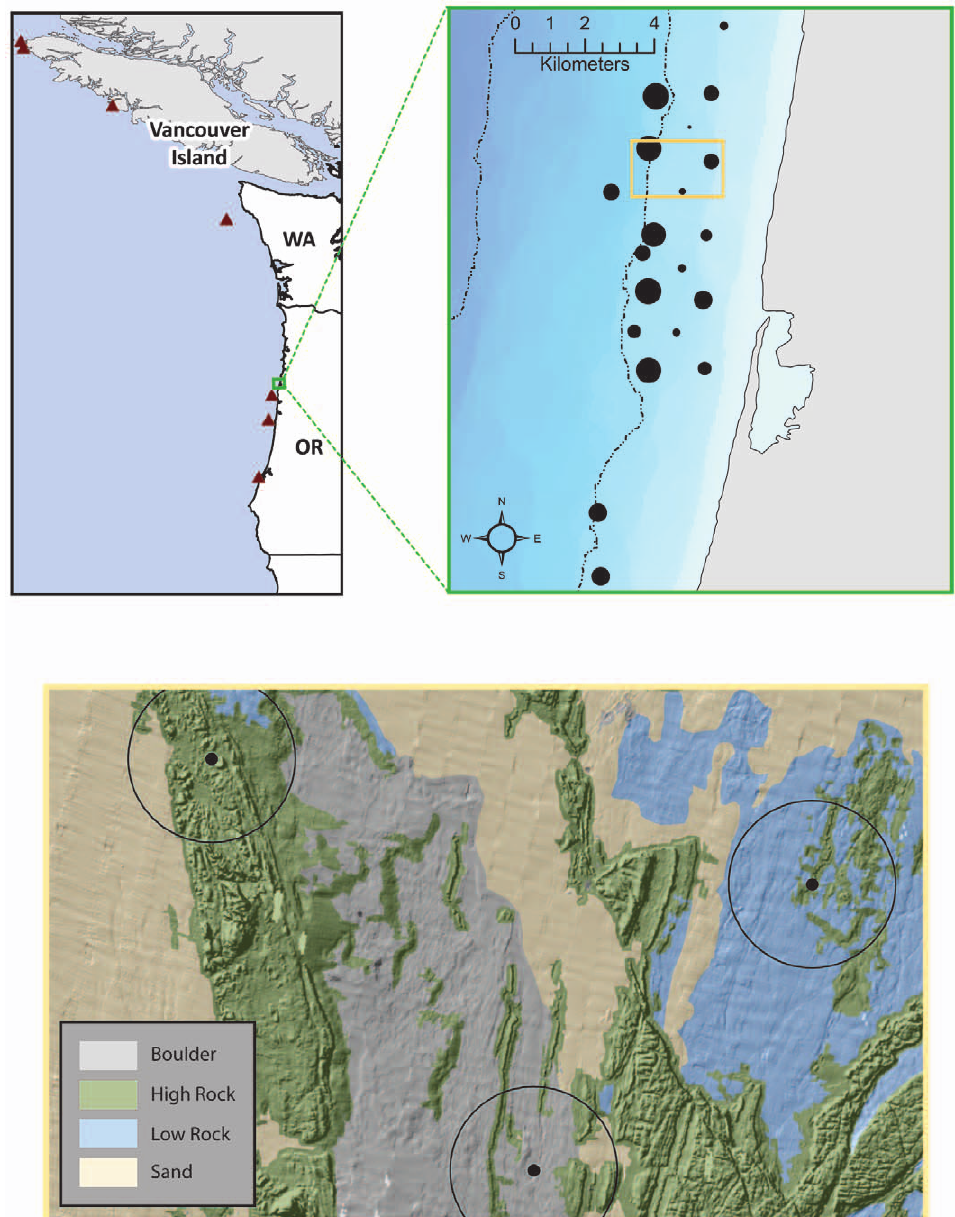
Figure 1. Map of the study area. Top-left inset : Overview of Oregon and Washington, USA coast with hydroacoustic receiver array area outlined in green. Red triangles indicate PAT detachment locations. Top-right inset : overview of hydroacoustic receiver array with black dots that represent individual hydrophones sized proportionally so that larger dots indicate greater duration of green sturgeon presence (min=1, max=19, mean=8.2 days per station). Dotted lines indicate 40 m bathymetric depth contours. The tan-colored outline box indicates the area shown in the bottom inset. Bottom inset : detailed view of a portion of the study area with hill shaded bottom topography overlaid with substrate type. Circumscribed black dots indicate hydrophone locations with 250 m buffers. doi:10.1371/journal.pone.0025156.g001 relief rock (R 2 = 0.790), which is defined as hard surface with a non-linear surface in the top-left contour plot in Figure 3, generally increased from left to right. All of the habitat greater than 45 u angle. The strongest negative linear relationship components except three (depth, eastern aspect, and sand) with the horizontal axis, was the proportion of sand (R 2 = 0.644), whereas the strongest negative non-linear variable was depth exhibited an increasing relationship (both linear and non-linear) (R 2 = 0.576). The BPI categories all had positive relationships with the horizontal axis scores from left to right, and therefore with the horizontal axis, the strongest of these was the proportion duration of sturgeon presence. The strongest positive relationship of habitat that are upper slopes (linear R 2 = 0.629), also known as with the horizontal axis by linear correlation was rugosity escarpments [29], and peak/ridges (non-linear R 2 = 0.733) which (R 2 = 0.641), which represented structural complexity. The strongest non-linear positive relationship was the proportion high are simply high points in the terrain.